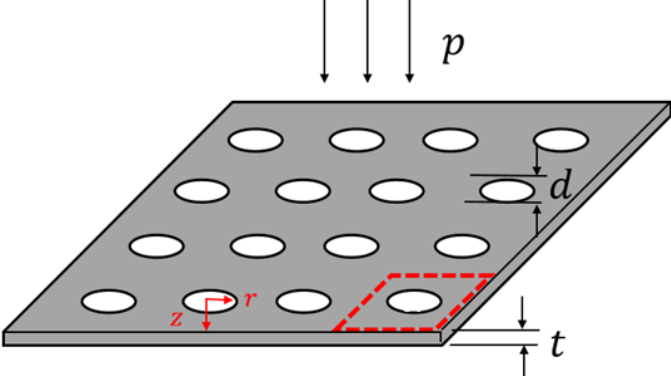
Figure 3. Schematic of the microperforated panel (MPP).